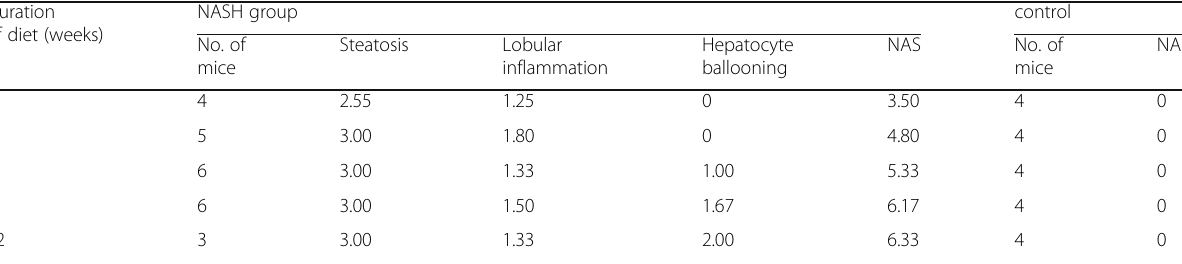
Table 1 NAFLD activity score Duration NASH group control of diet (weeks) No. of Steatosis Lobular mice inflammation